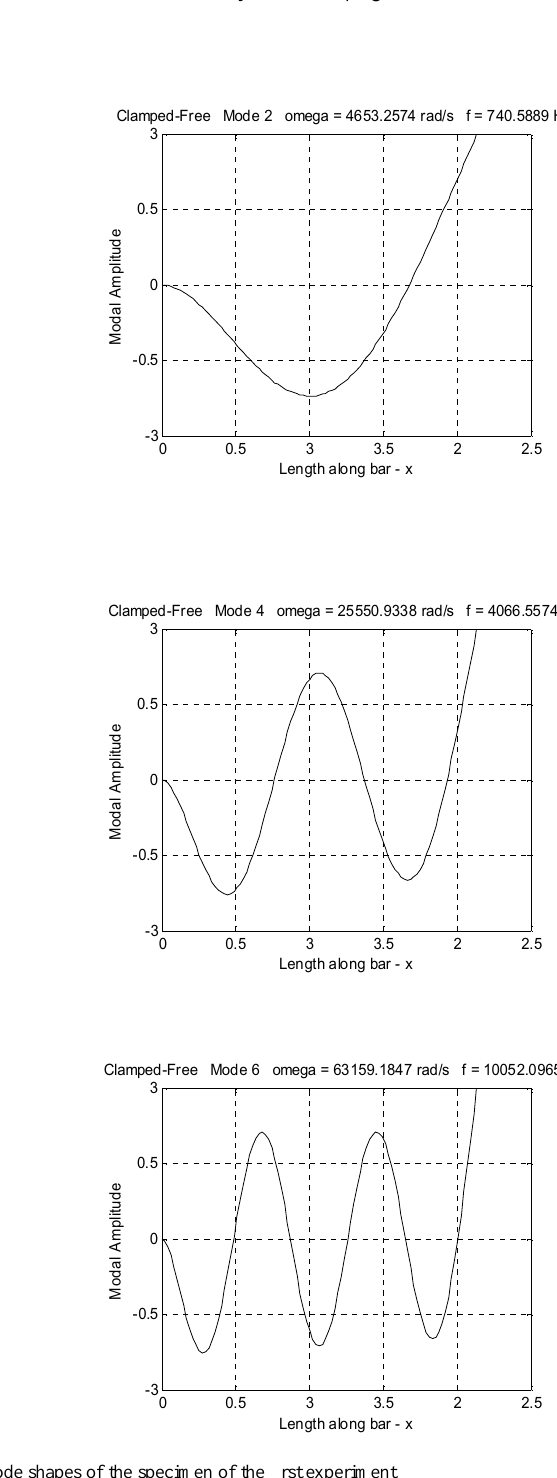
Fig. 10. Natural frequencies and mode shapes of the specimen of the first